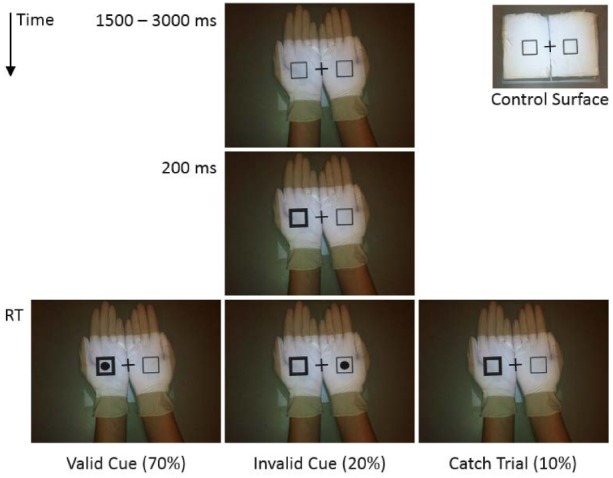
Response time plotted as a function of cue validity, hand position, and role (A). Participants were slower to respond to invalidly cued targets on their hands relative to off their hands, but only when stimuli appeared on their own hands and not when they appeared on another person’s hands. The cost to detecting an invalidly cued target is expressed as the difference between RTs for validly and invalidly cued targets (B). Error bars represent one within-subjects standard error of the mean.